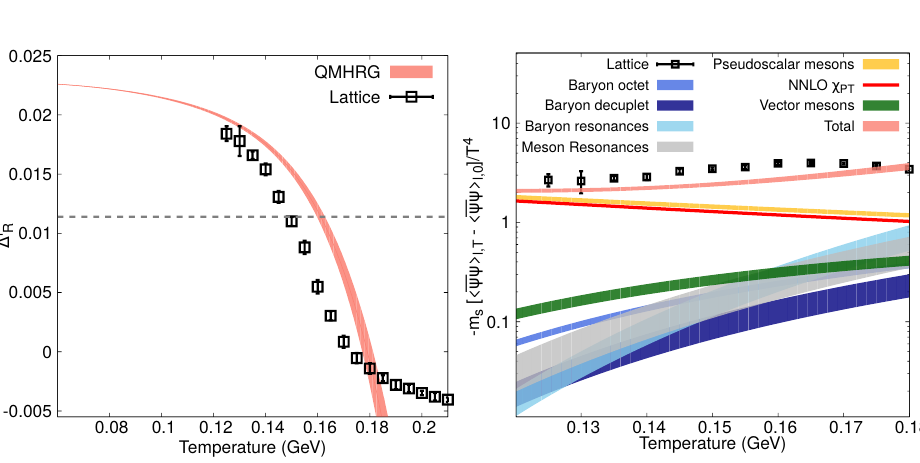
Figure 1. (Left) ∆ l is compared to the lattice data taken from Ref. [7]. The dotted line denotes R the half-value of ∆ l compared to its magnitude at the lowest temperatures, which is used as a cri- R terion to determine T c . (Right) The relative contribution to the subtracted light quark condensate, (cid:2) ⟨ ¯ (cid:3) − m ψψ ⟩ l , T − ⟨ ¯ ψψ ⟩ l , 0 / T 4 due to di ff erent meson and baryon channels is shown and the resultant total s contribution within QMHRG (orange band) is compared to the lattice data from Ref.